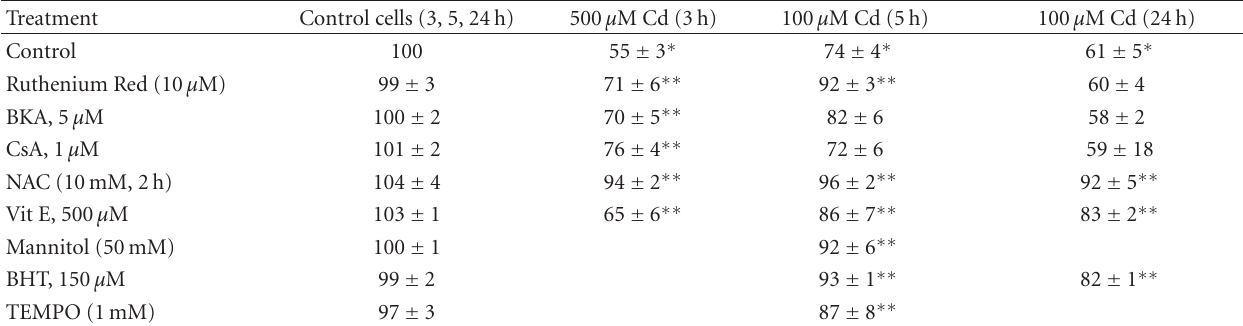
Table 5: Action of di ff erent antioxidants and MPT pore inhibitors on viability of PC12 cells assessed by LDH release after di ff erent time of incubation with di ff erent concentration of Cd 2+